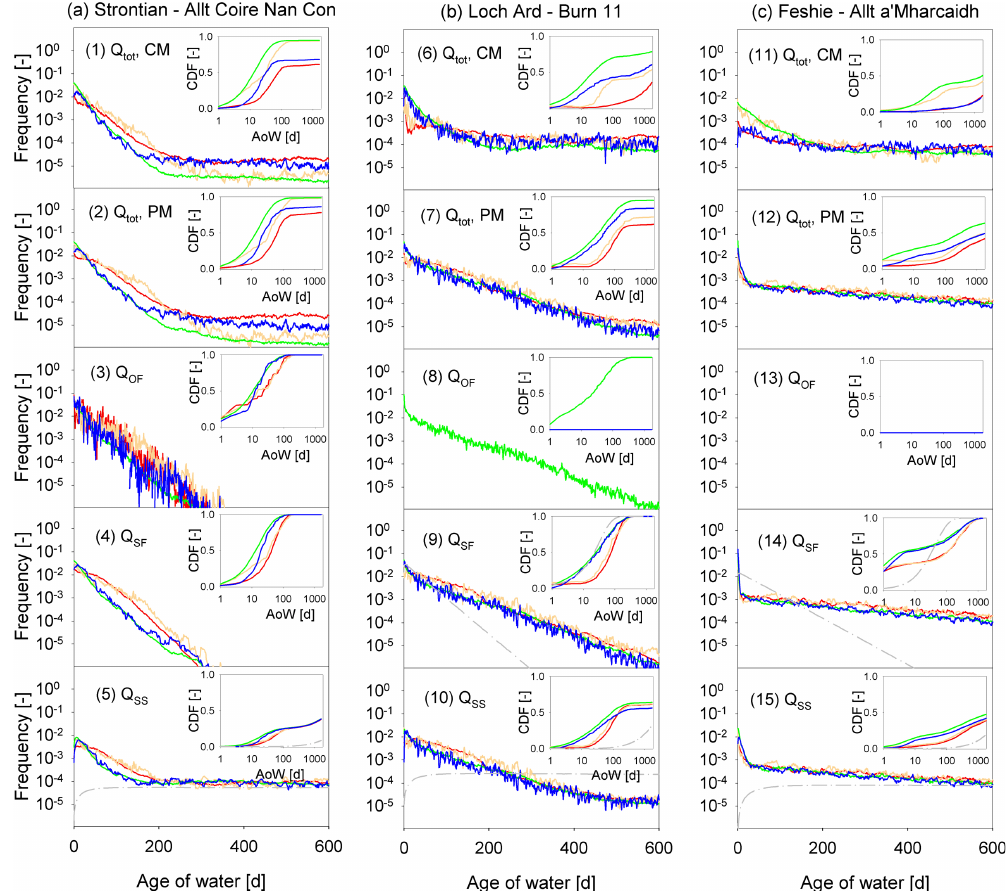
Fig. 6. Temporally averaged, unweighted flux water age distributions p F for all runoff generating components of the three study catchments for each of the four pre-defined hydrological regimes. The averages were constructed from the median water ages for all time steps within the respective hydrological regime. CM indicates results from the complete mixing scenario and PM from the partial mixing scenario. The panels below the first row show the full results of PM scenarios and only where significant differences were found, the temporally averaged, unweighted results of the CM scenario constructed from the median of all values for the entire time series is given (grey, dash-dotted line) in addition. The color code of the lines is corresponding to the four hydrologic regimes defined in Fig. 5: red (dry), yellow (wetting-up), green (wet) and blue